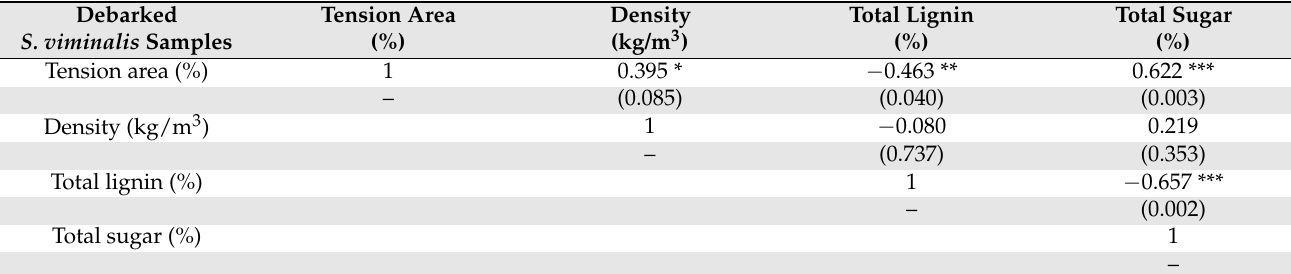
Table 2. Pearson r ( p -value) for correlation between tension area, density, total lignin, and sugars.